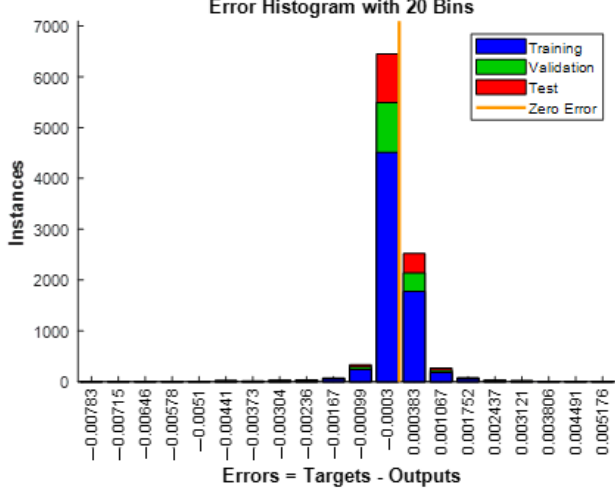
Figure 7. Error histogram with 10 neurons and 200 epochs.